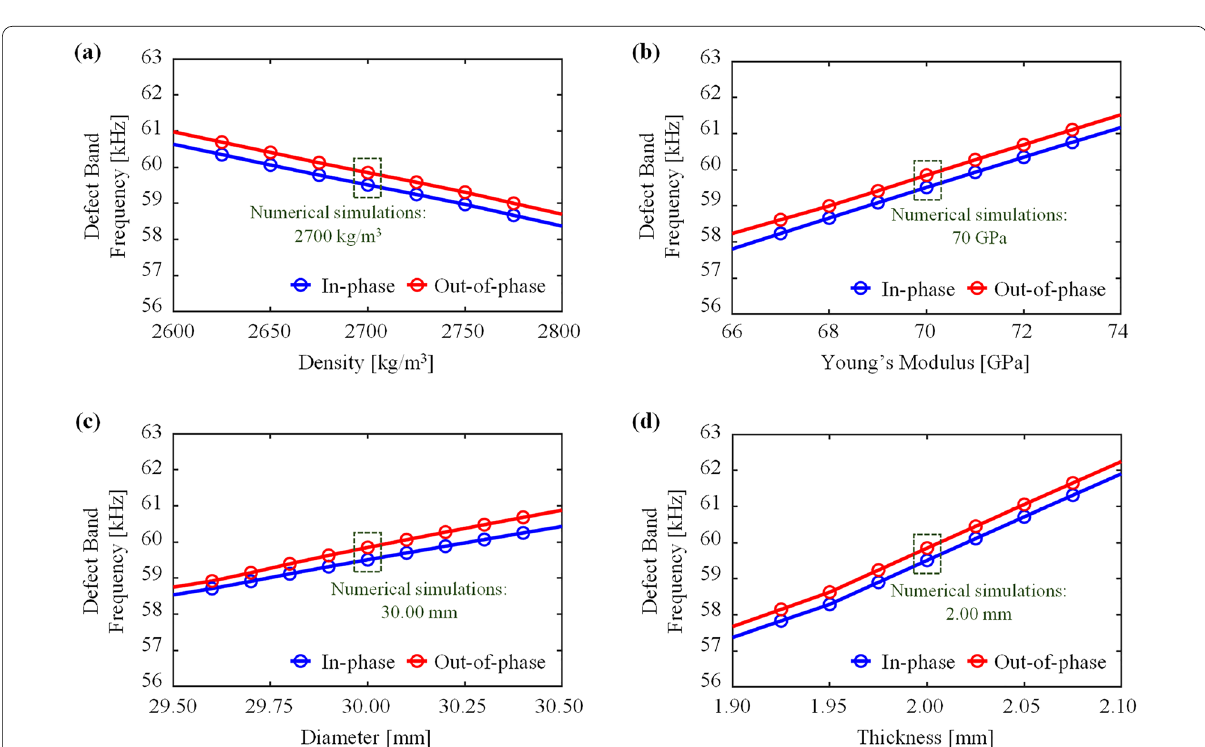
Fig. 6 Sensitivity analysis results of the defect band frequencies that correspond to the in‑phase and out‑of‑phase monopole‑like defect modes in terms of material properties and geometric variation. a Effects of the mass density of the aluminum plate, ranging from 2600 to 2800 kg/m 3 . b Effects of Young’s modulus of the aluminum plate, ranging from 66 to 74 GPa. c Effects of the diameter of the circular hole, ranging from 29.50 to 30.50 mm. d Effects of the thickness of the unit cell, ranging from 1.90 to 2.10